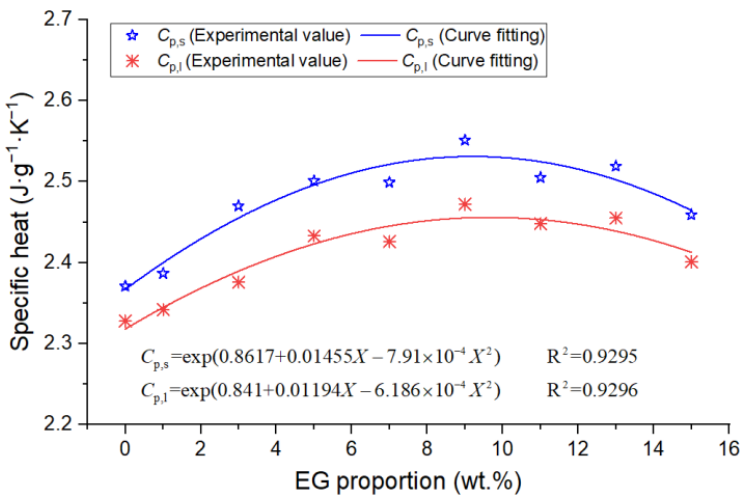
Figure 10. The specific heat capacity of PCMs.